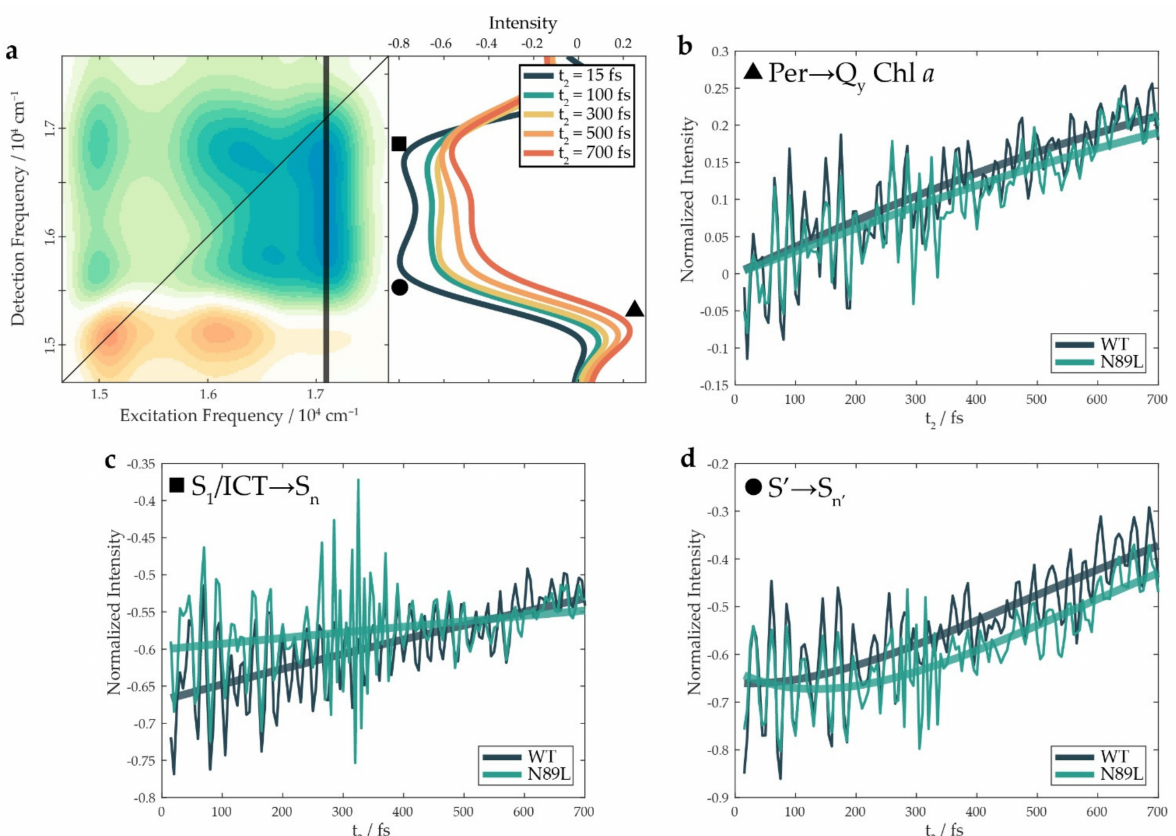
Figure 3. ( a ) Vertical cuts of the 2DES maps of WT PCP at excitation frequency 17,066 cm − 1 (indicated with the black line) at different population times; to ease the visualization of the signal trends, the oscillating contributions to the signal were attenuated using a Savitzky–Golay filter. Temporal traces of ( b ) the ET signals (extracted at (17,066, 15,100) cm − 1 , triangle), ( c ) the higher frequency ESA signals (extracted at (17,066, 16,700) cm − 1 , square) and ( d ) the lower frequency ESA signals (extracted at (17,066, 15,850) cm − 1 , circle) for the WT and the mutant samples. Thick solid lines represent the fittings performed according to the multiexponential model described in Section S3.1 (only the non-oscillating components are shown for